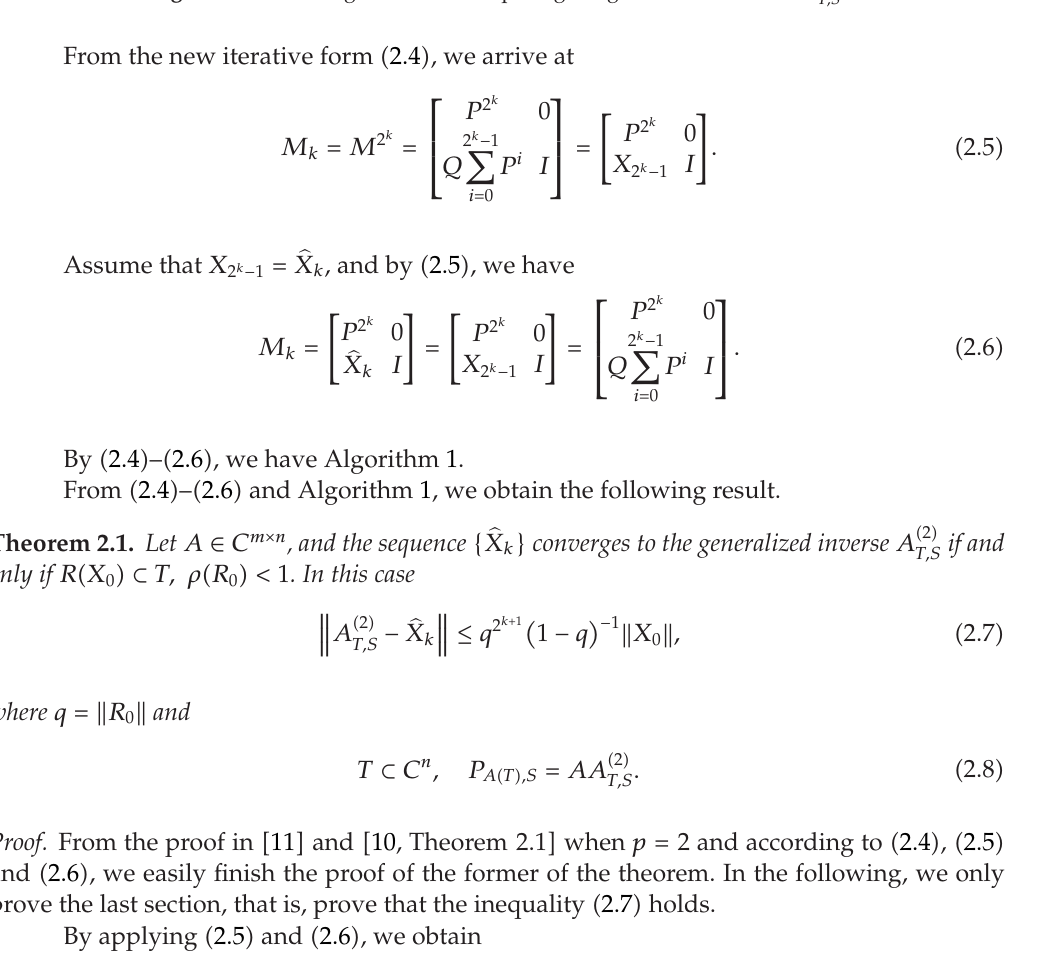
Algorithm 1: SMS algorithm for computing the generalized inverse A